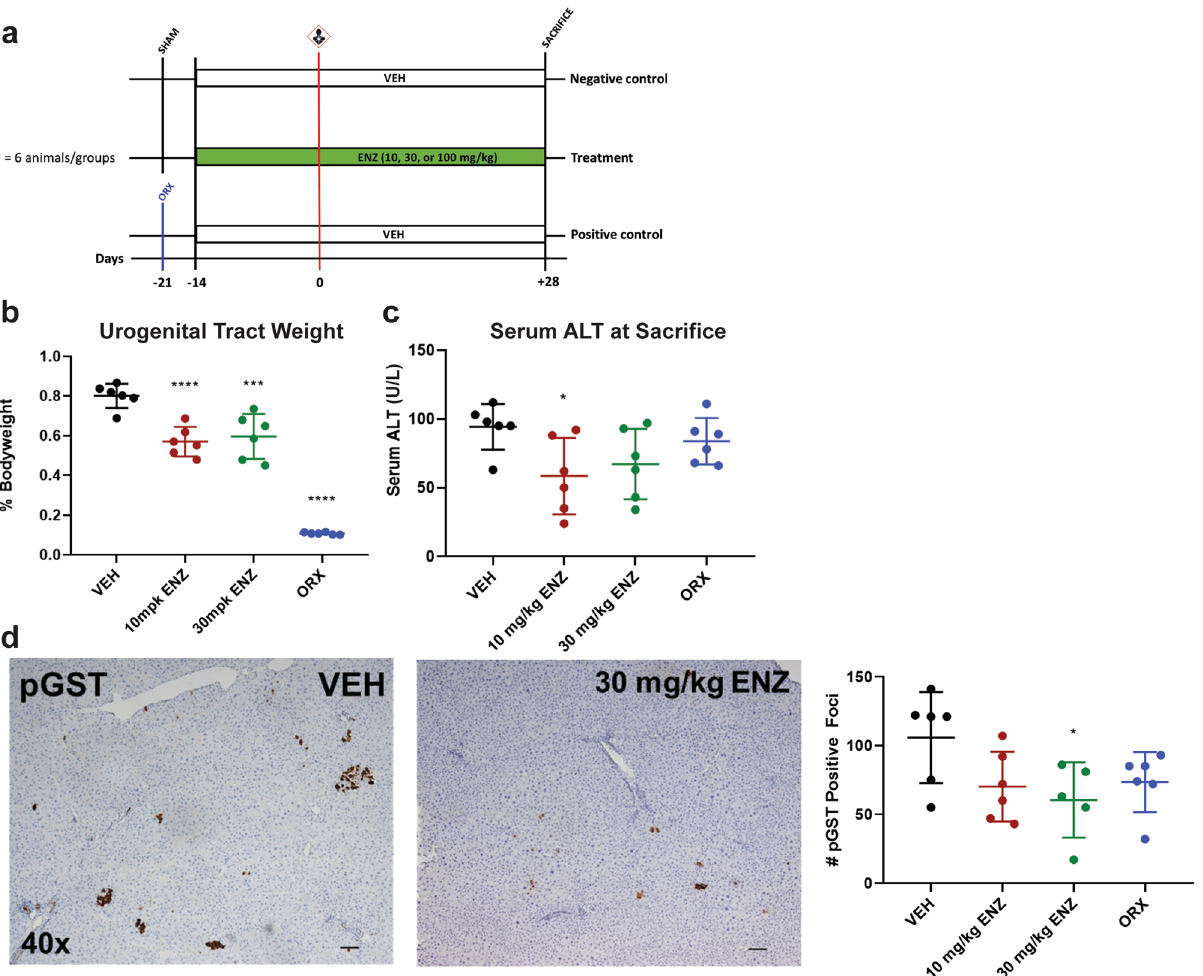
Figure 1. Low dose, preventive ENZ inhibits DEN-induced hepatocellular carcinogenesis. ( a ) Study Design— simplified timeline highlighting preventive anti-androgen interventions. Carcinogen challenge consisting of the described DEN/PH/DEN procedure is represented by carcinogen pictogram. SHAM, sham castration; ORX, castration. Enzalutamide (ENZ) groups received 10, 30, or 100 mg/kg and control groups received vehicle (VEH), all once daily by oral gavage. Carcinogen-challenged, preventive ORX served as anti-androgen phenotype positive controls; carcinogen-challenged, SHAM rats served as anti-androgen phenotype negative controls. ( b ) Low-dose ENZ maintained an anti-androgen effect on bodyweight-normalized urogenital tract weights. *** p < 0.0005; **** p < 0.0001 (vs. VEH), one-way ANOVA followed by Dunnett’s multiple comparisons. ( c ) ENZ at 10 mg/kg reduced liver damage marker, serum ALT(U/L). * p = 0.0298 (10 mg/kg ENZ vs. VEH), one-way ANOVA followed by Dunnett’s multiple comparisons. ( d ) ENZ at 30 mg/kg reduced the number of pGST-positive, preneoplastic foci. Left, Representative photomicrographs (40 × total magnification) of IHC for pGST for VEH (left) and 30 mg/kg ENZ (right) treatment groups. Right, Comparison of the total number of pGST-positive foci between treatment groups. * p = 0.033 (30 mg/kg vs. VEH), one-way ANOVA followed by Dunnett’s Multiple Comparisons. All data represented as mean ± standard